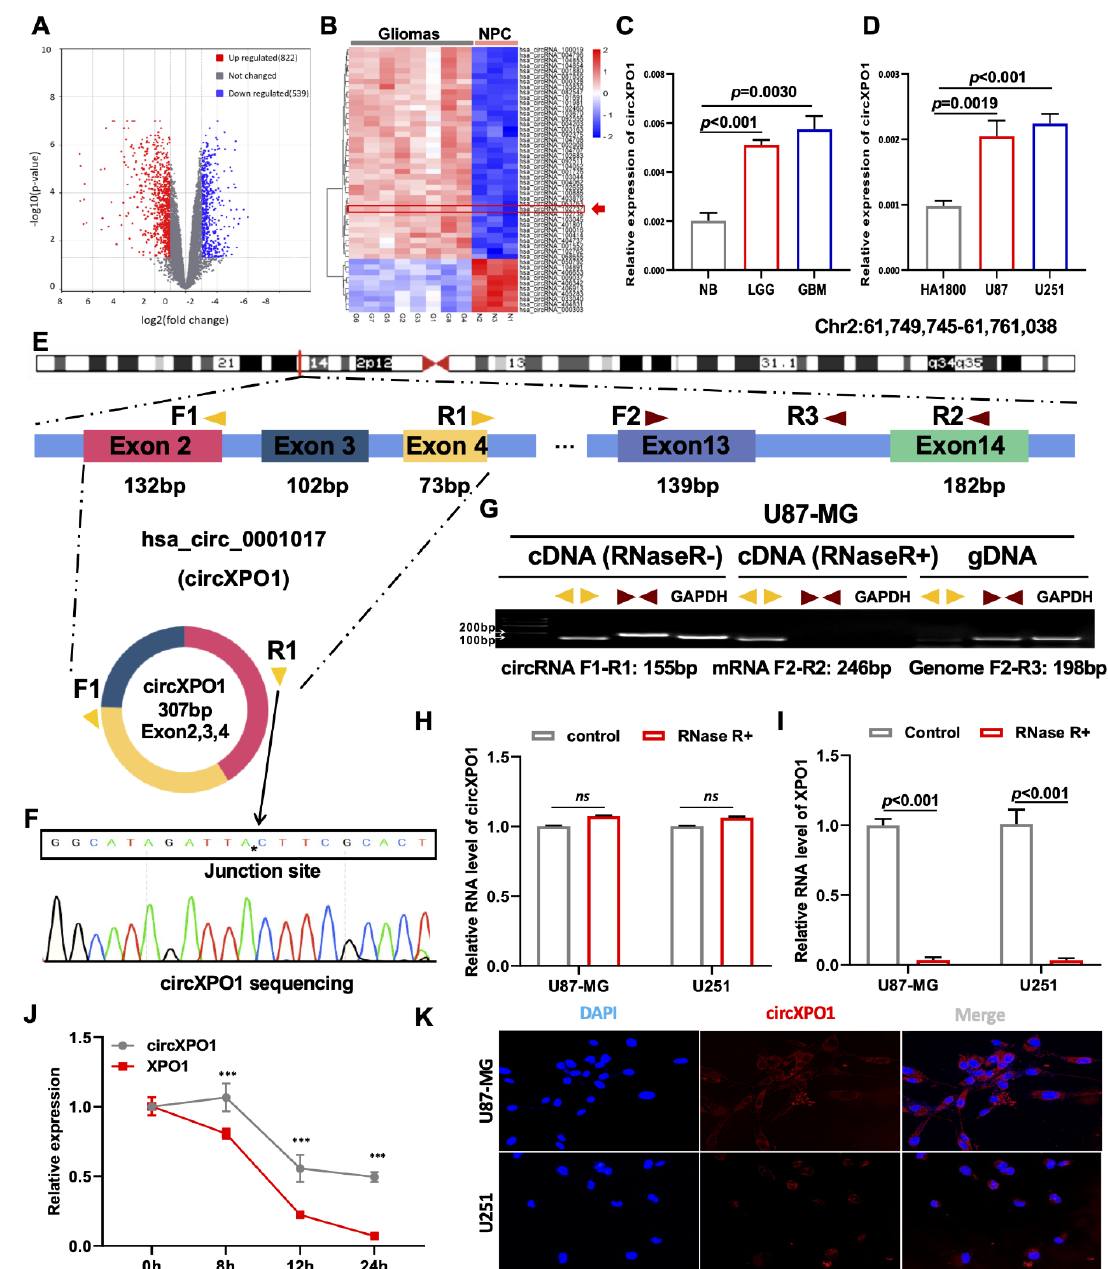
Figure 1. circXPO1 is highly expressed in GBM. ( A ) The volcano plot of differentially expressed circRNAs in GBM with 822 upregulated and 539 downregulated. ( B ) Heatmap generated from hierarchical clustering of 1361 differentially expressed circRNAs between GBM cells and neural progenitor cells (NPC). ( C ) Quantitative real-time PCR (qPCR) identified elevated circXPO1 expression in glioma tissues and tumor cell lines ( D ) vs. normal controls. ( E ) Schematic graph illustrates the sequence composition of circXPO1 (hsa_circ_102737), and the divergent primers (yellow) and convergent primers (brown) were designed to amplify the back-splicing and linear products. ( F ) The “*” represents the “head to tail” splicing site of circXPO1 verified by Sanger sequencing. ( G ) RT-PCR products with divergent and convergent primers were detected through agarose gel electrophoresis. ( H , I ) RNase treatments were applied to evaluate the stability of circXPO1 and linear XPO1 mRNA. ( J ) Actinomycin D treatment was applied to determine the half-life of circXPO1 and linear XPO1 mRNA. “***” indicates p < 0.001. ( K ) RNA ISH clarified the subcellular localization of circXPO1 in GBM